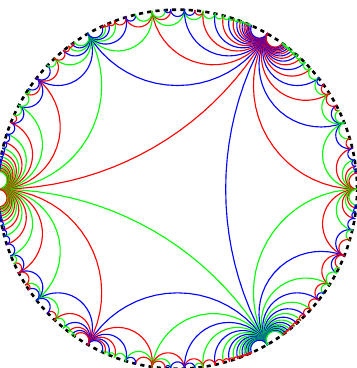
Figure 4 . The triangle group ( ∞ , ∞ , ∞ ) on the Poincaré disk, which corresponds to the universal Coxeter group of rank 3. In the context of the infinite flop examples for Picard rank 3 CYs discussed here, each arc corresponds to a flop wall. Arcs with the same color are reflection images of one